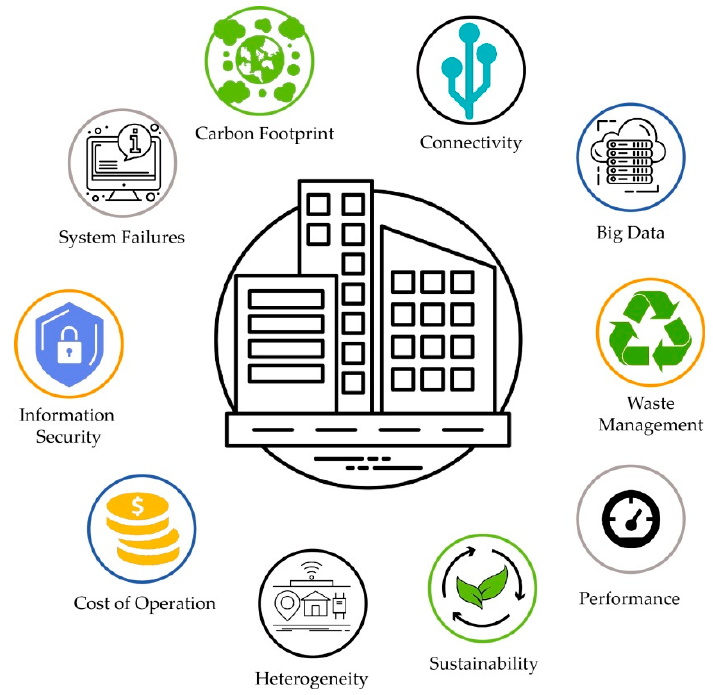
Figure 1. Architectures and components in smart cities [15].